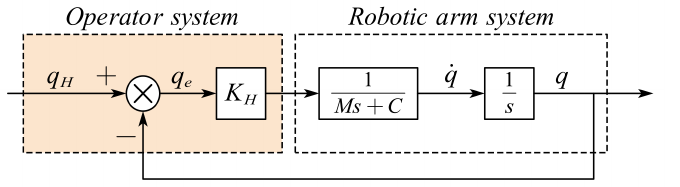
Figure 8. Equivalent control block diagram of human–computer interaction system.